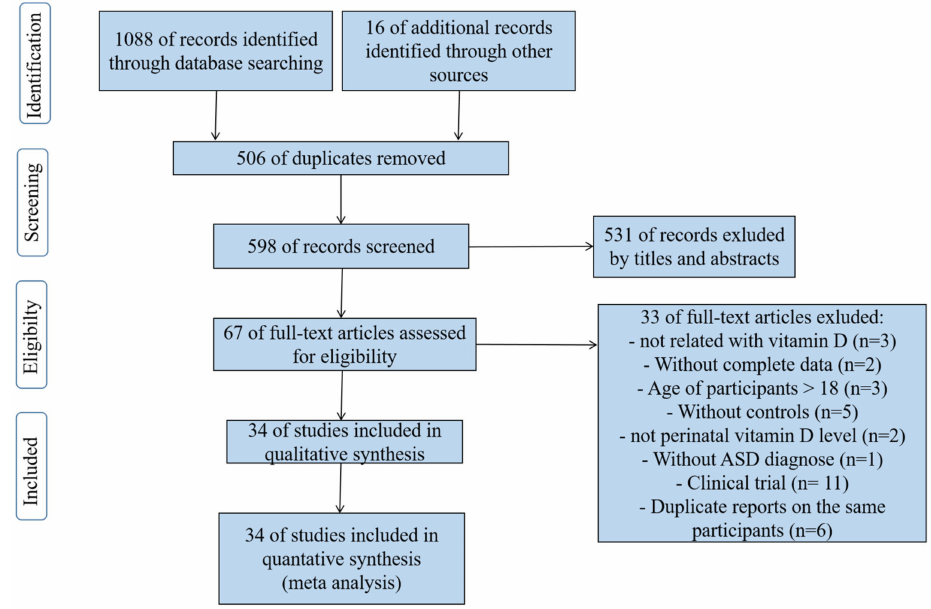
Figure 1. Flow chart of identification of eligible